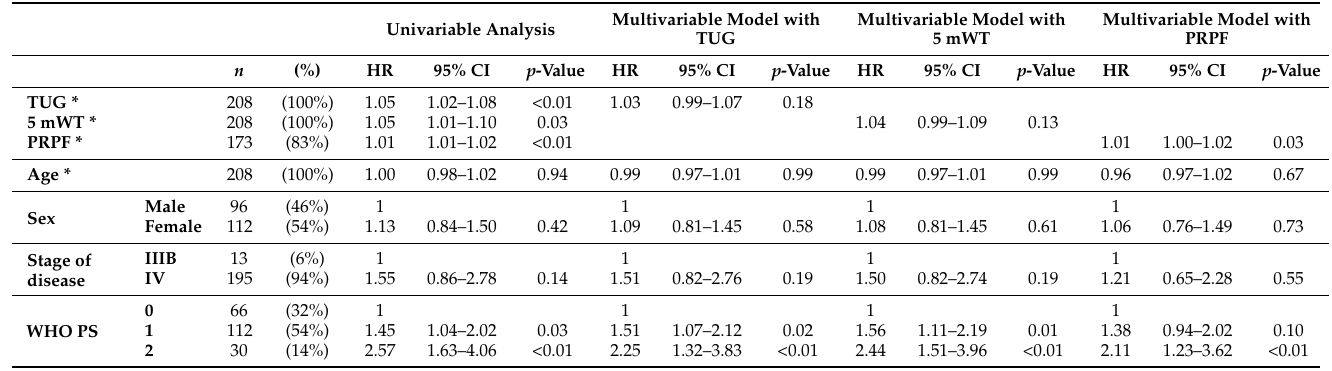
Table 2. Survival analyses.